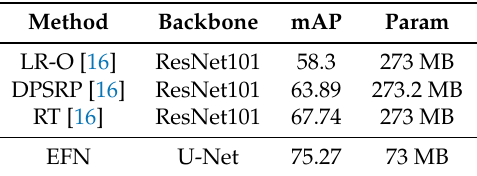
Table 2. Comparison of memory use.